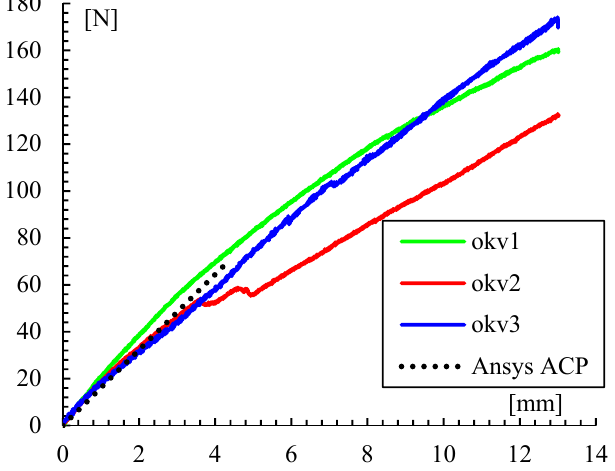
Figure 11. Load-displacement comparison of experimental results and the numerical model.